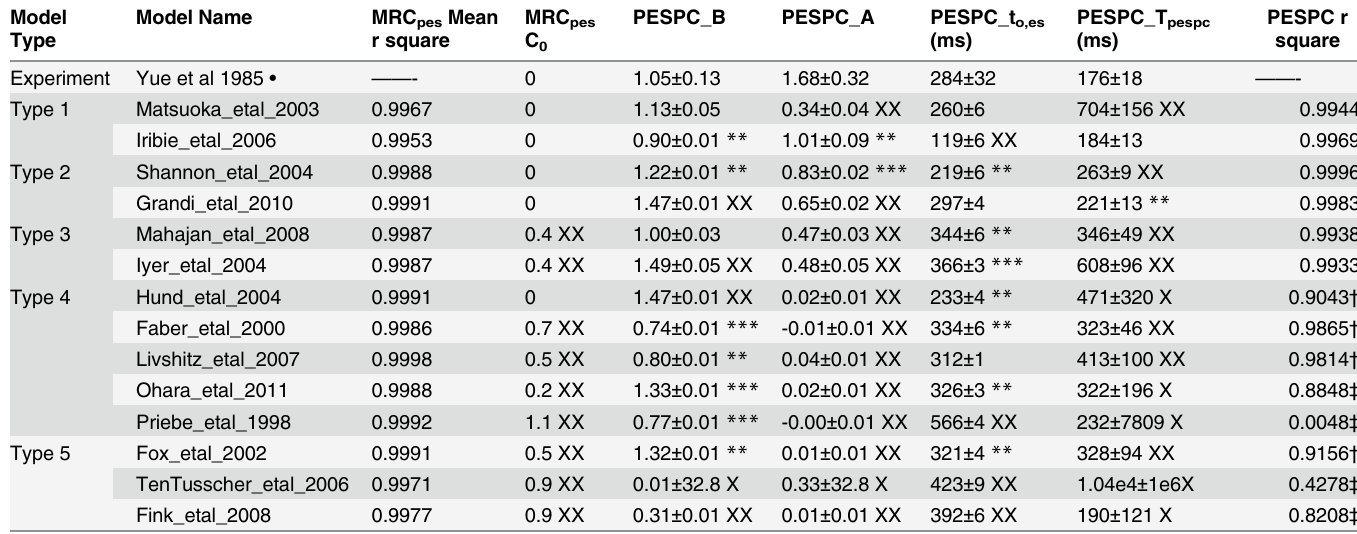
Table 8. Contraction parameters: MRC pes and PESPC. Model